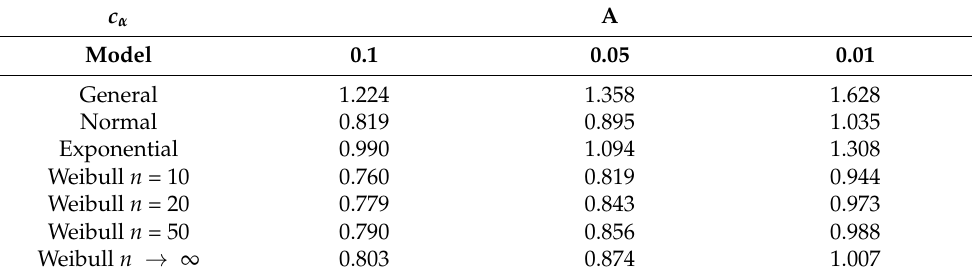
Table 1. C α values according to the model and the significance.